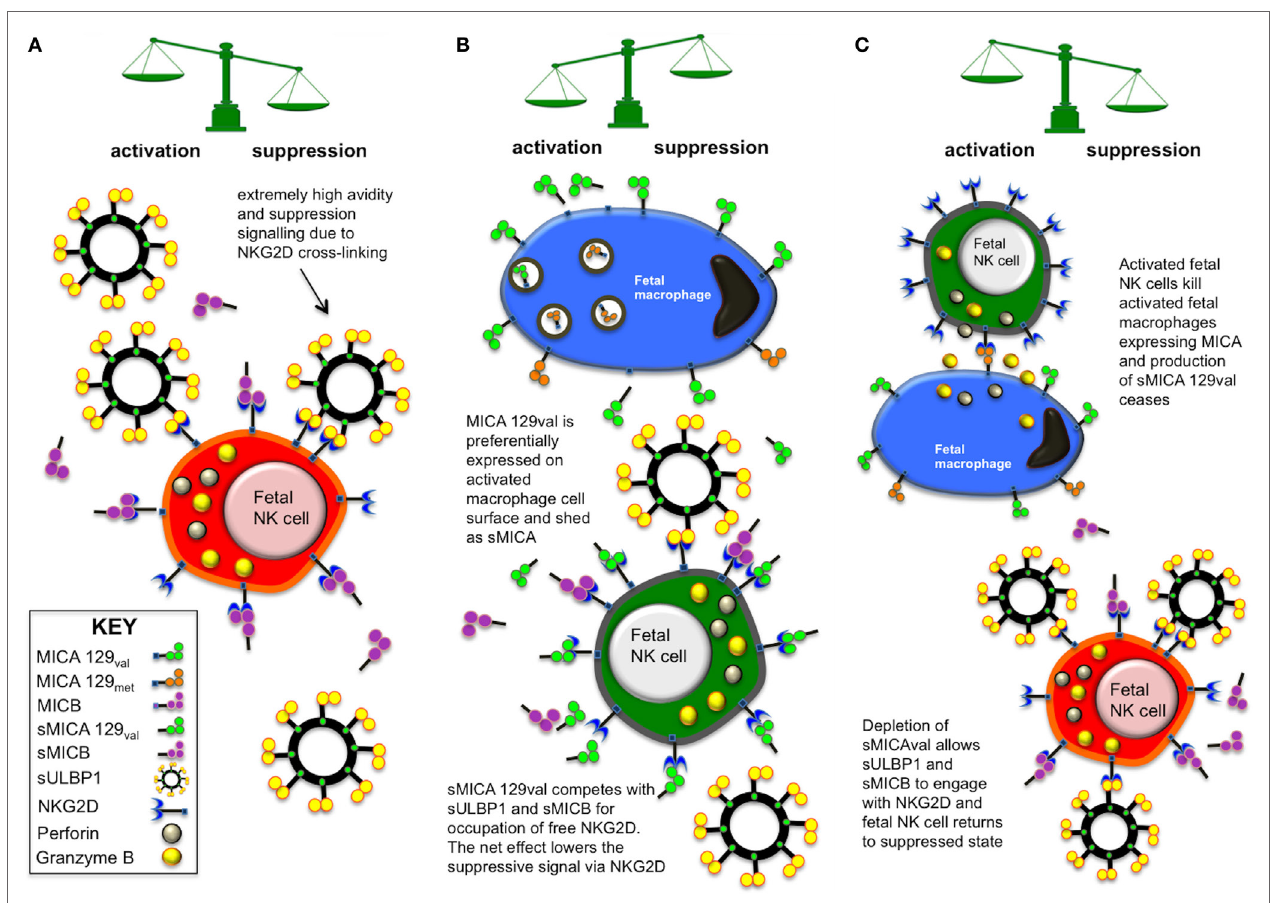
FigUre 10 | Model of in utero fetal immune suppression and tolerance mediated via soluble NKG2D ligand (NKG2DLs) interaction with fetal natural killer (NK) cells. (a) Under normal circumstances, an abundance of sMICB and sULBP1 binds with available NK group 2, member D (NKG2D) receptors on fetal NK cells and renders them hyporesponsive to activating stimuli at the maternal:fetal interface, promoting tolerance. In the particular, the very high concentration of high-avidity multivalent exosomal sULBP1 is a powerful suppressor of NK cells and may crosslink NKG2DLs. (B) In situations where opportunistic infection arises, innate immune cells such as macrophages may upregulate surface expression of MHC class I-related chain A (MICA) when activated but mechanisms exist preventing expression of MICA-129met variants, which are retained in cytoplasmic vesicles and degraded. The macrophage expression of MICA-129val may be a source of sMICA due to metalloprotease cleavage from the cell surface. Low-avidity sMICA-129val is then able to compete for binding with NKG2D, reducing the overall net suppressive signal to the NK cell. This may result in the NK cell hyporesponsiveness or tolerance being broken, enabling the NK cell to become activated and help in clearing the opportunistic infection. (c) Once the immunological threat has been dealt with, the remaining activated macrophages can be eliminated via interaction of NKG2D with cell surface MICA, which stops the production of sMICA-129val. NK cells are then able to return to a suppressed state as sMICB and sULBP1 engage available NKG2D